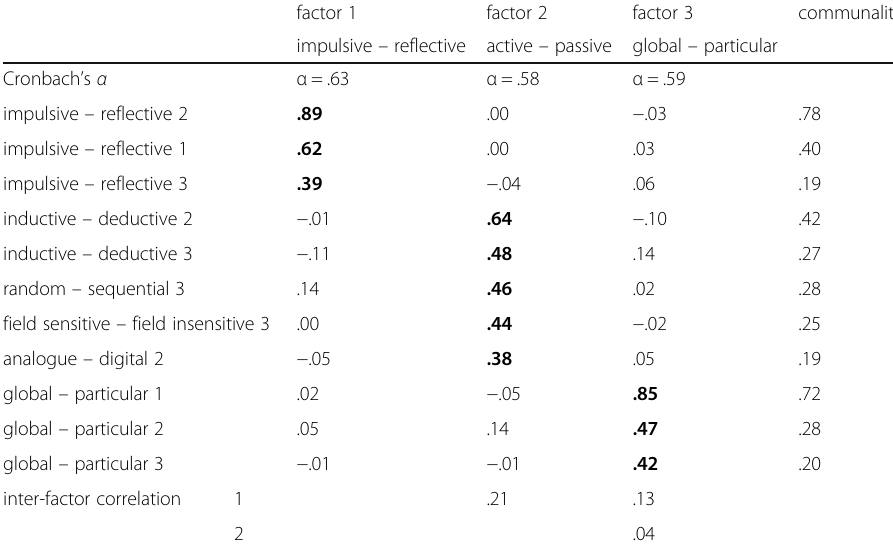
Table 3 Factor loadings, communalities, and inter-factor correlations factor 1 factor 2 factor 3